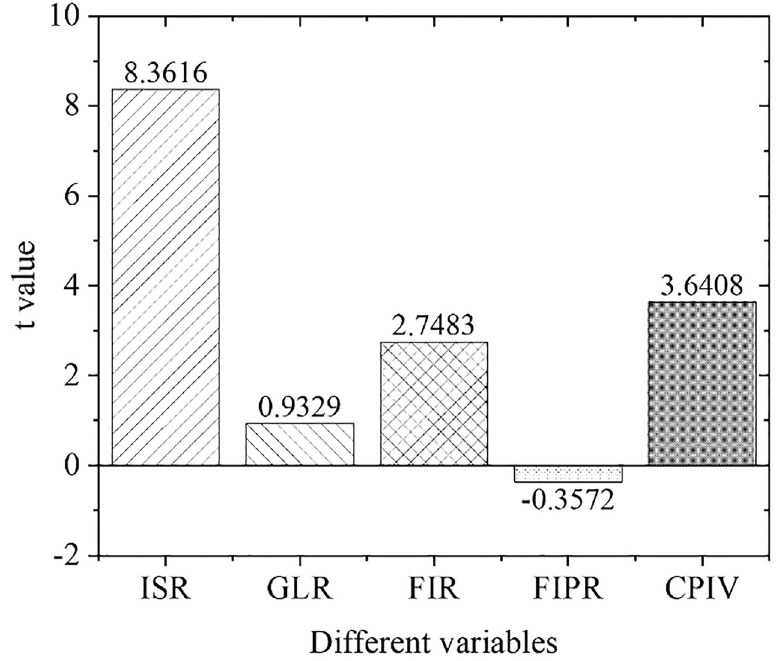
Fig 10. Calculation results of t value in Central China.